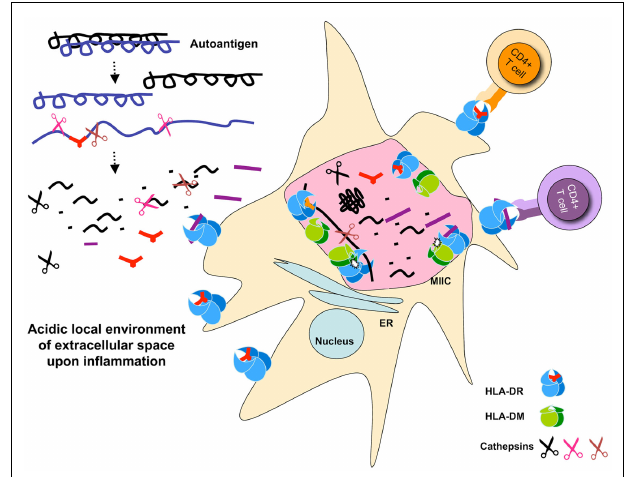
FIGURE 1 | Schematic representation of auto-antigen-processing pathways . Auto antigen-derived epitopes are resistant to cathepsins degradation, and may or may not be sensitive to DM-mediated peptide exchange. Auto-antigens may be processed extracellularly and bind MHC II expressed on the surface of dendritic cells. Paralyzed DCs display a large number of MHC II on their surface because of exhaustive processing that occur under inflammatory conditions presumably associated with the initiation of autoimmune diseases. Processing for pathogen-derived antigens occurs in the MIIC shown as a giant pink vesicle within the DC. Cathepsins are shown as scissors, peptides, and epitopes are depicted as part of the denatured proteins, or in short stretches of sequences that carry a MHC II P1 fitting anchor or no anchor. The selected pMHC complexes are transported to the APC cell surface waiting for T cell stimulation. Small dots represent degraded peptides. Cell sizes are not depicted correctly proportionally.